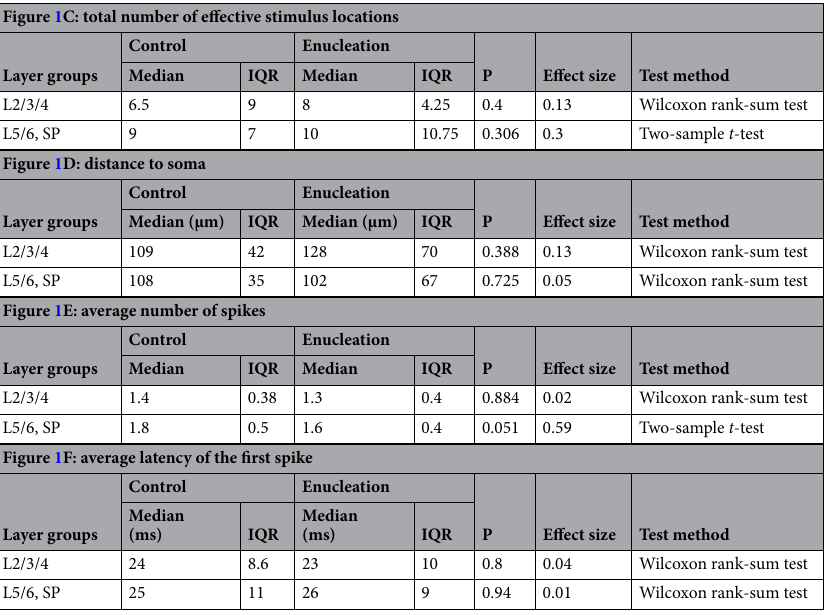
Table 1. Statistics in Fig. 1. IQR interquartile range.